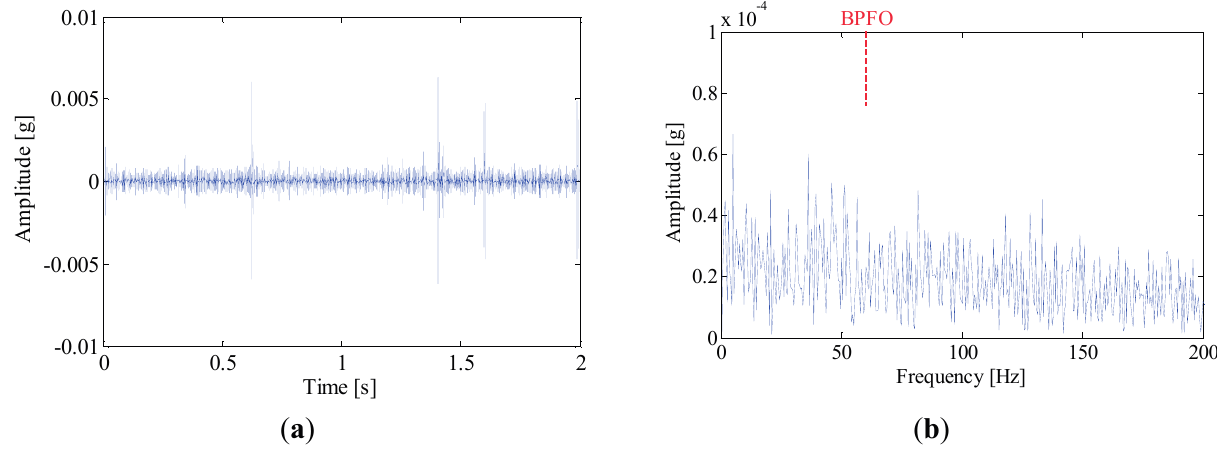
Figure 17. ( a ) Waveforms and ( b ) envelope spectrum of the band-pass filtered